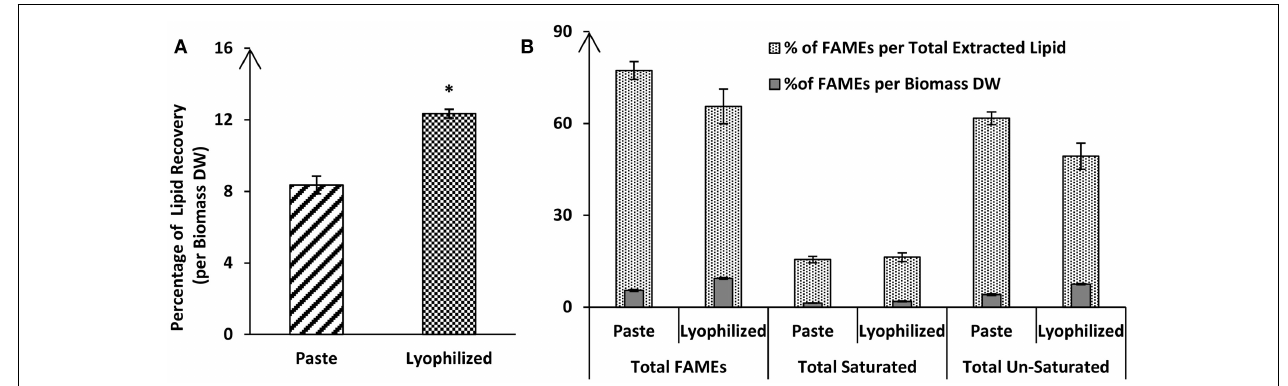
contents ( ± SD) relative to biomass dry weight (DW) and/or total extracted lipids from three independent extractions. Asterisks represent significant statistical differences ( P < 0.05) between lyophilized a wet algal biomass.